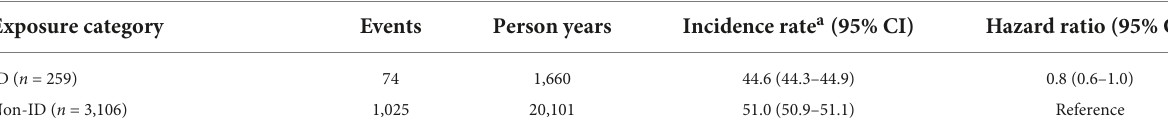
TABLE 2 Estimated hazard ratios for reconvictions, comparing ID and non-ID offenders, adjusted for potential confounders (age, sex, previous convictions, and parental educational level). Offenders sentenced to forensic psychiatric care ( n =